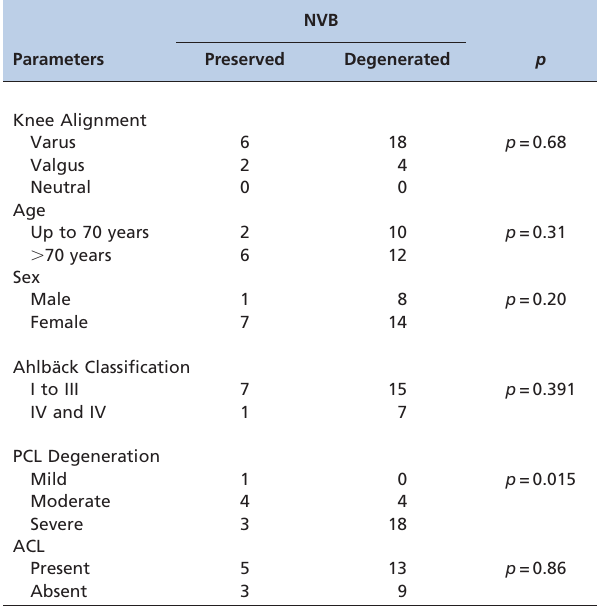
Table 2 - Correlation between the studied parameters and the state of conservation of the PCL’s subsynovial